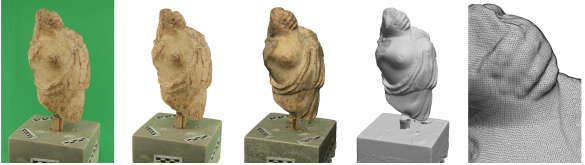
Figure 7: Offline/Online database managment